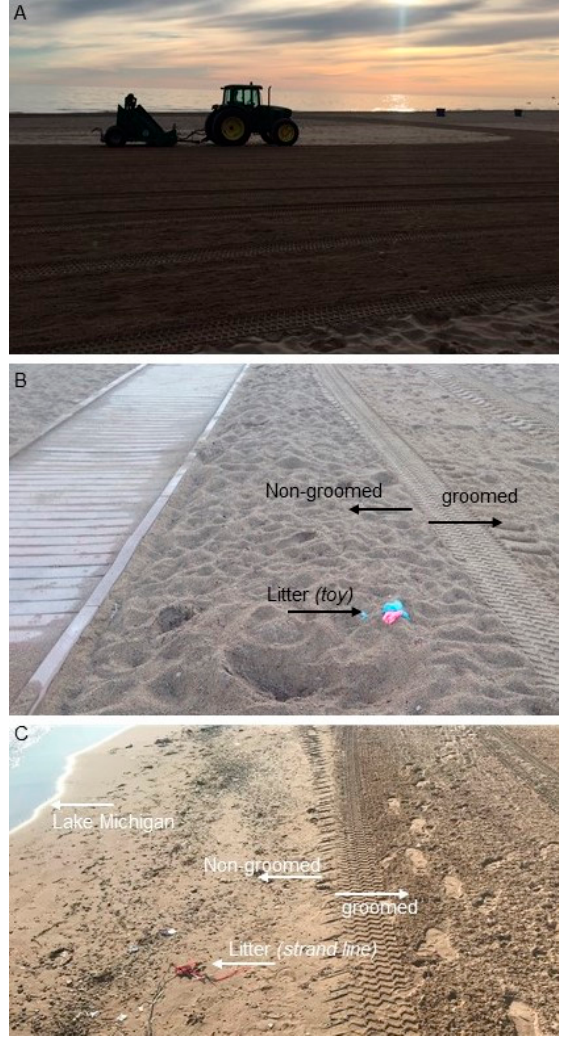
Figure A1. Municipal litter maintenance for Lake Michigan beaches in Chicago. ( A ) A grooming tractor and trailer collects litter at dawn every day during the summer. ( B ) A sidewalk facilitating handicap access to the lake shows the distance maintained by grooming tractors from obstacles. ( C ) Shoreline litter missed by grooming tractors.